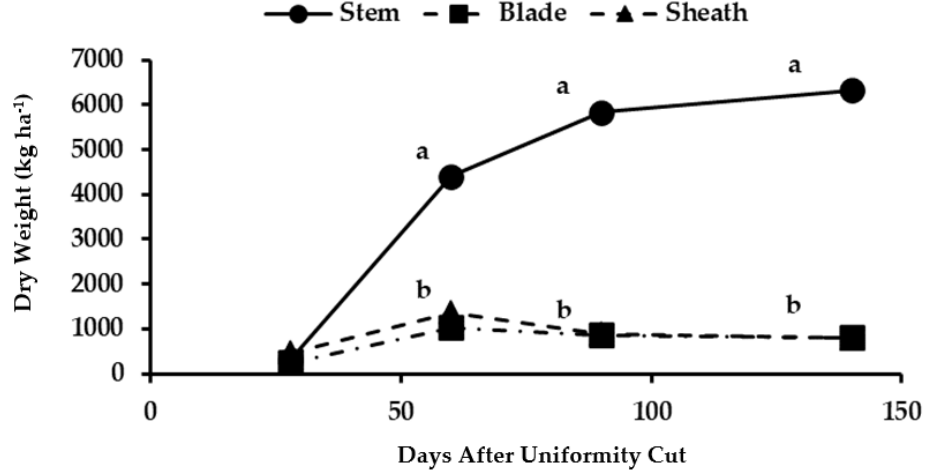
Figure 5. Dry biomass accumulation at different organs of the basal stratum of maralfalfa plants harvested at different cutting dates. The weight values with equal letters in each stratum of the plant were statistically similar ( p ≤ 0.05).